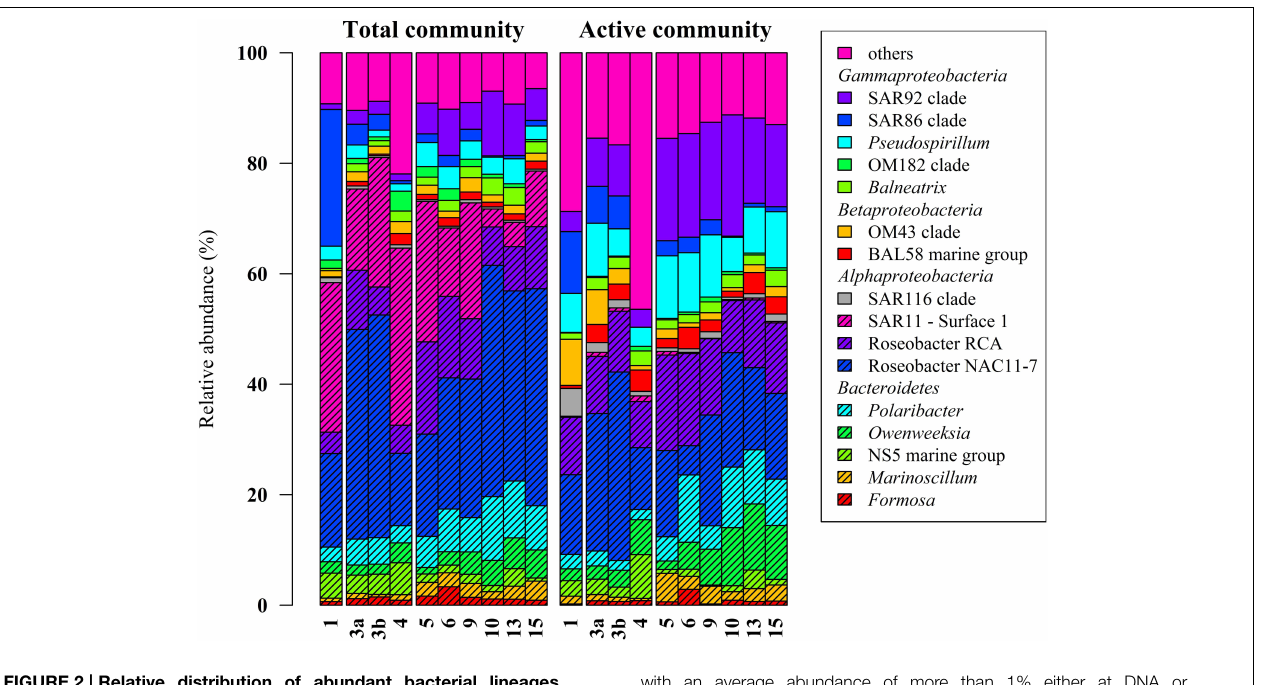
with an average abundance of more than 1% either at DNA or RNA level are shown. Station 1 is separated from the oher samples because it was located in a bloom outside of the area of the examined